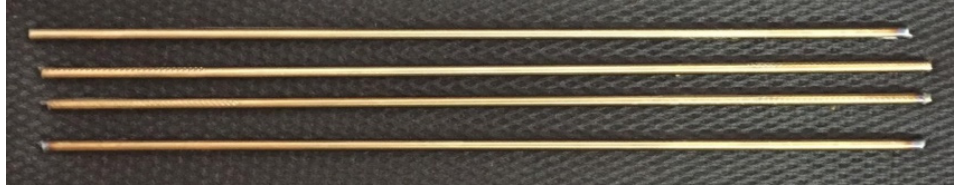
Figure 2. NiTi SMA bars with the diameter of 5.5 mm. The test device adopts the CMT (Crane Motor Traction) electro-hydraulic servo